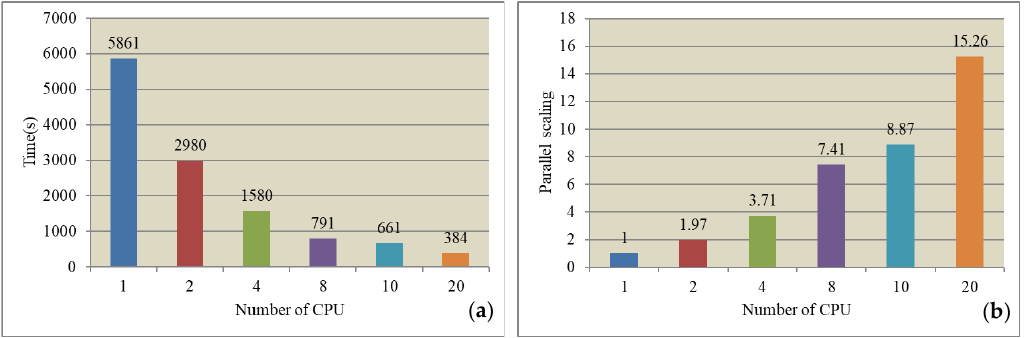
Figure 11. Time ( a ) and parallel-scaling ( b ) comparisons of 2D MT-parallel-constrained-inversion.